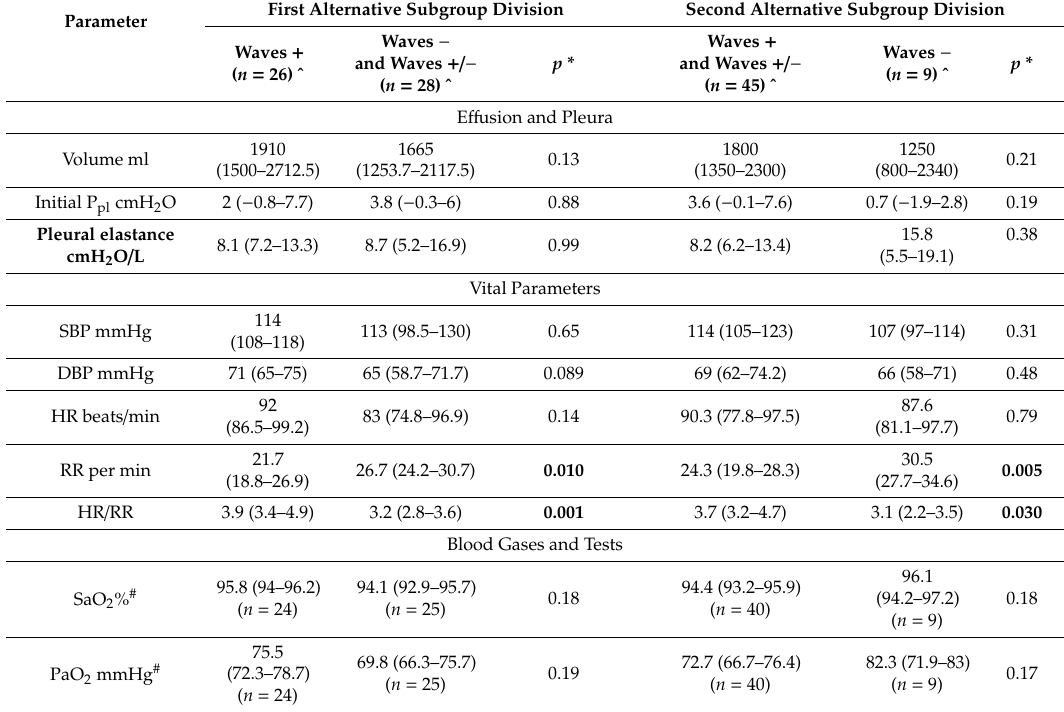
Table 3. Comparison of vital signs, pulmonary, and echocardiographic parameters using two di ff erent patient